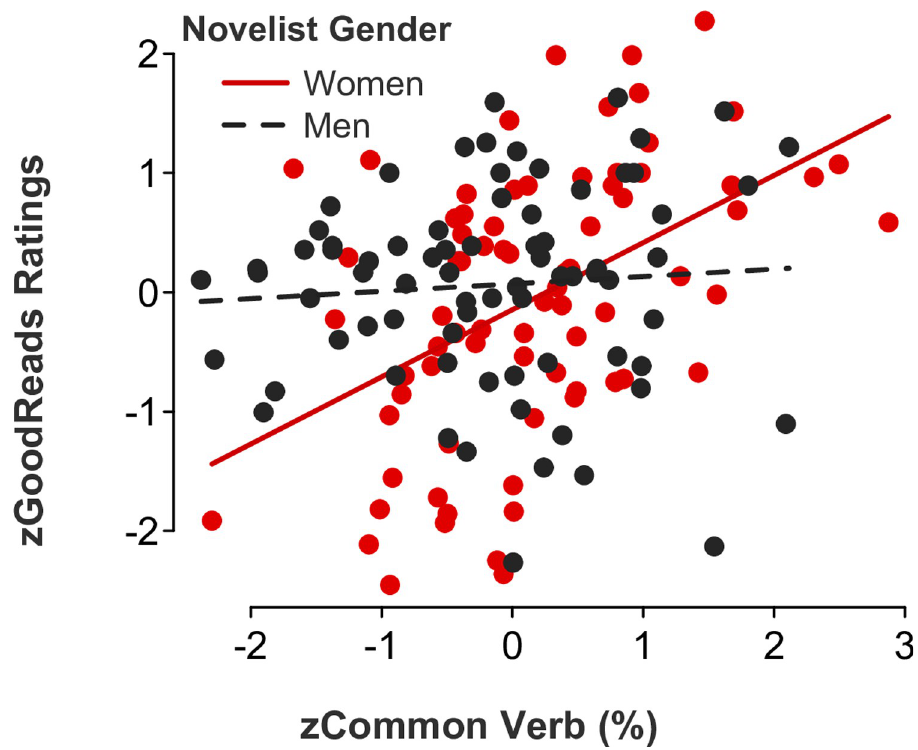
Fig 9. Novel ratings as a function of common verb use and novelist gender.